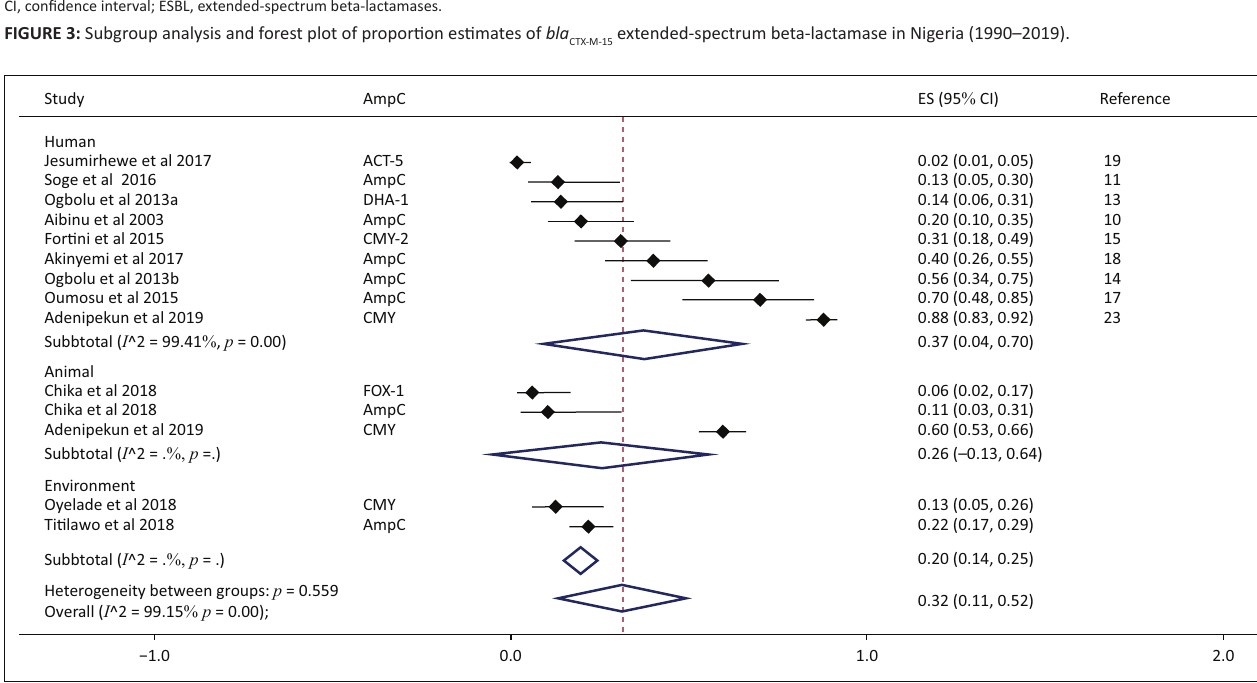
Note: Midpoint of each horizontal line segment shows the proportion estimate of bla resistance gene in each study. Diamond sign represents the pooled proportion from all studies included CTX-M-15 in the random-effect meta-analysis. P -values generated using STATA SE version 15.0 and does not represent exact values. CI, confidence interval. FIGURE 4: Subgroup analysis and forest plot of proportion estimates of AmpC beta-lactamases for human, animal and environmental settings in Nigeria